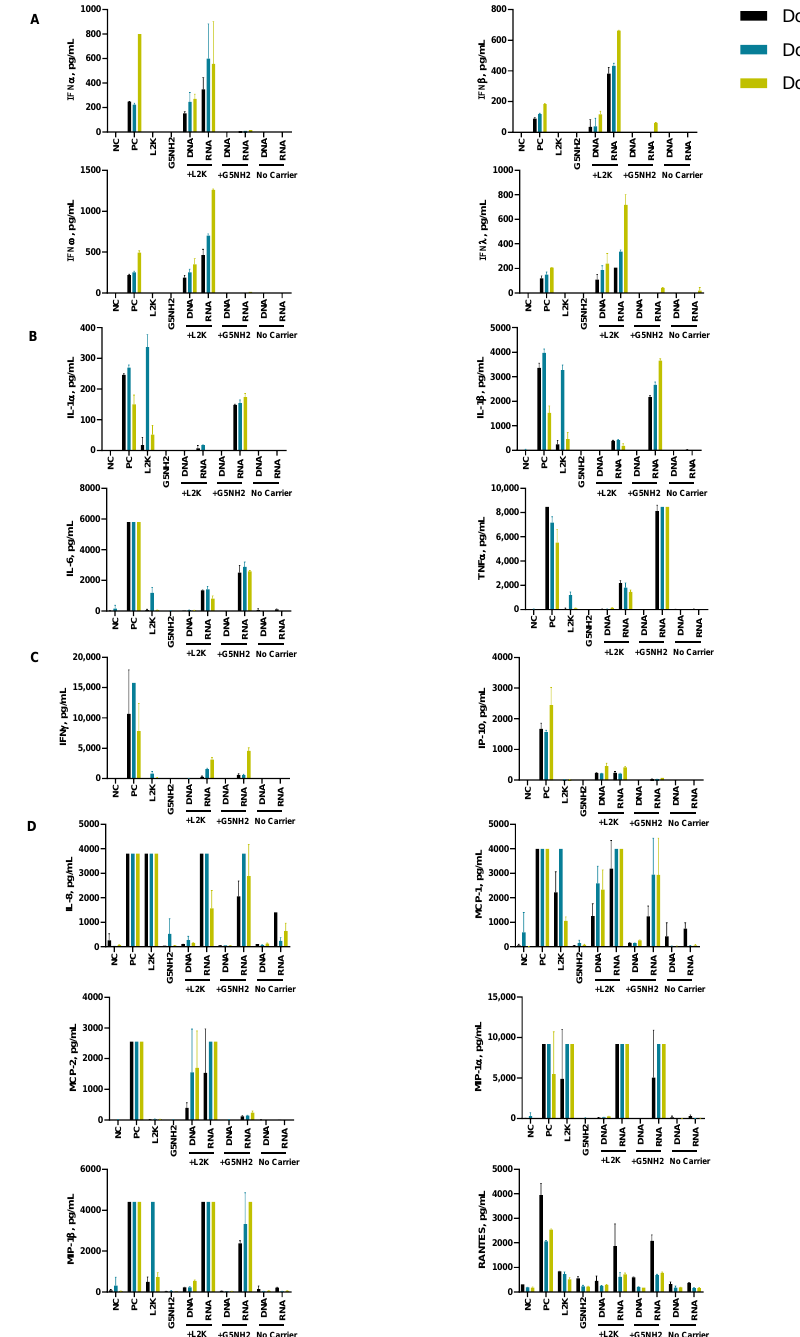
K NH 2 DNA RNA DNA RNA DNA RNA L 2 G 5